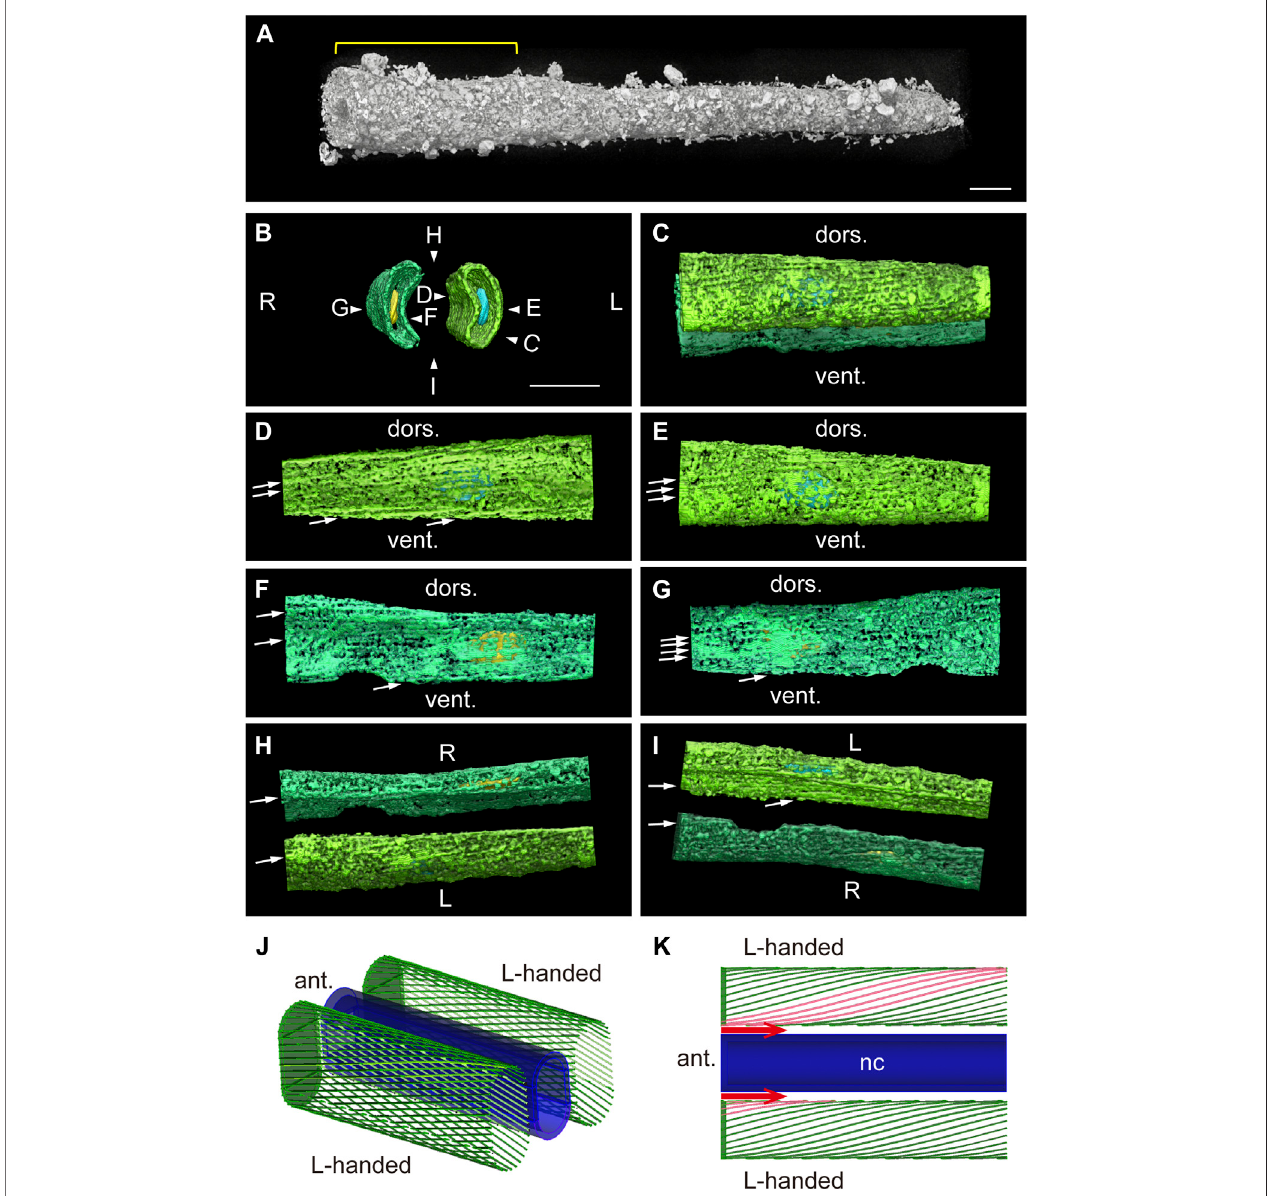
FIGURE 7 | Bilaterally asymmetric left-handed helical models of myo fi brils. (A) Laboratory-based Zernike X-ray tomographic microscopy of a Ciona tadpole larva neartheendofthetail.Theregionanalyzedin (B – I) isindicatedwithayellowline.Scalebar,10 μ m. (B) Anteriorviewoftheplasmamembraneofmusclecells(green)and nuclei.Pseudo-colors:rightnucleus,yellow;leftnucleus,blue.Scalebar,10 μ m.Viewdirectionsof (C – I) areindicated. (C) Leftview. (D) Medialsurfaceoftheleftmuscle cell.Thearrowindicatesthedirectionofamyo fi bril. (E) Lateralsurfaceoftheleftmusclecell. (F) Medialsurfaceoftherightmusclecell. (G) Lateralsurfaceoftheright muscle cell. (H) Dorsal view. (I) Ventral view. (J) Schematic image of two muscle cells containing left-handed (L-handed) helical myo fi brils paired on either side of the notochord (dark blue). (K) Schematic dorsal view of myo fi brils in left and right muscle cells. The model represents how neuronal stimulation (red arrows) could result in asymmetric contraction. nc, notochord. See also Supplementary Video S2